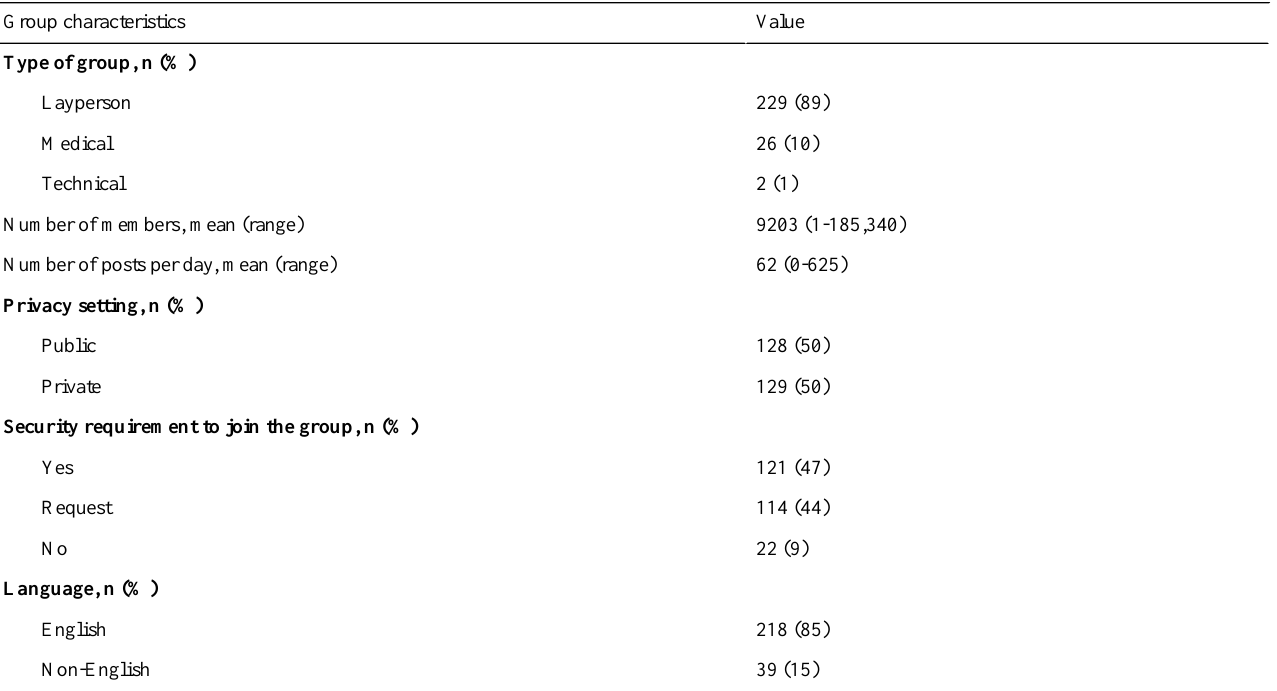
Table 2. Characteristics of COVID-19–related Facebook groups (N=257).